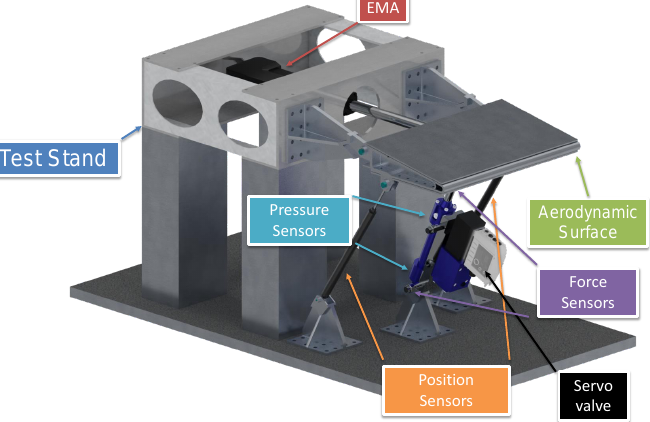
Figure 1. MIB (Modular Iron Bird) Test Stand